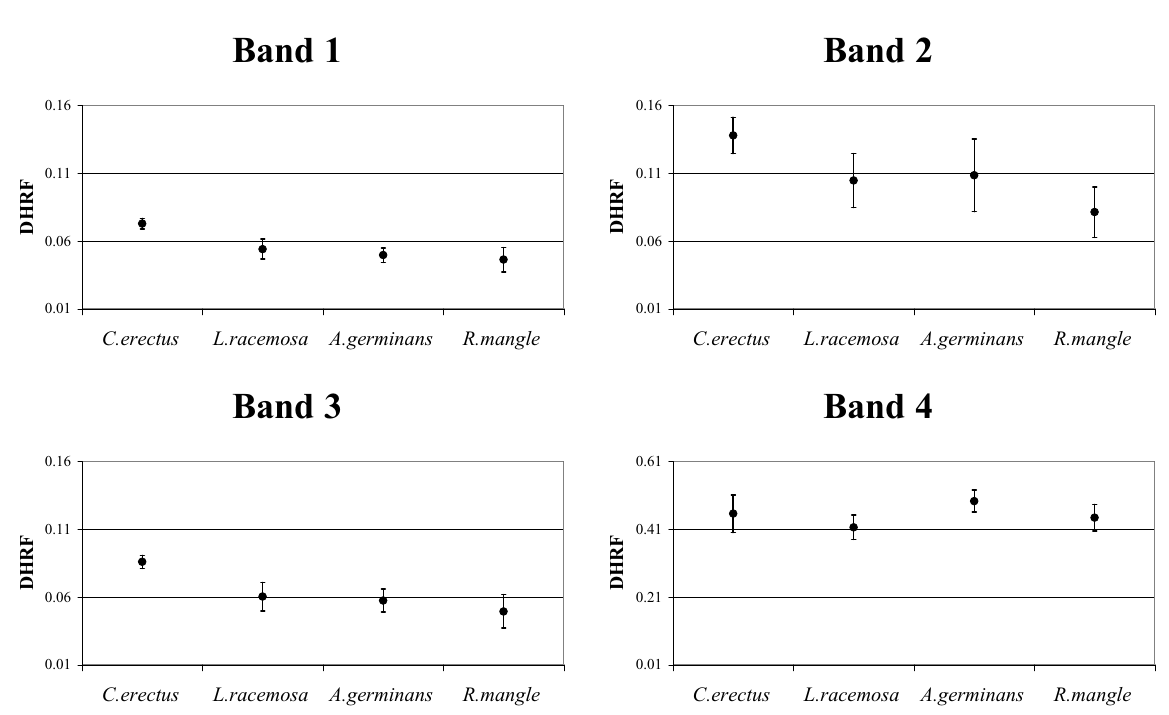
Fig. 3 – Averages and standard deviation of HFR in each spectral band for all